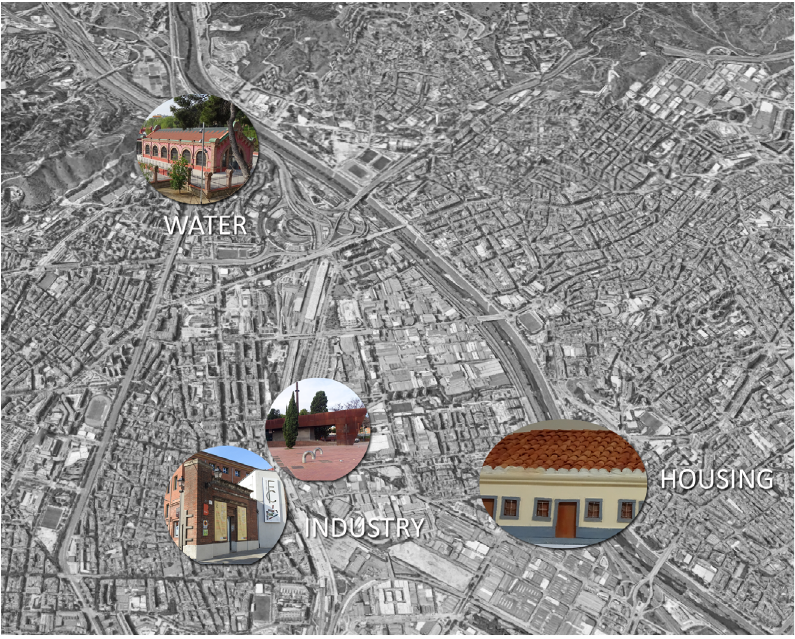
Museography decentralized plan of the MUHBA for the North of Barcelona. The thematic axes: Water, Industry, Popular